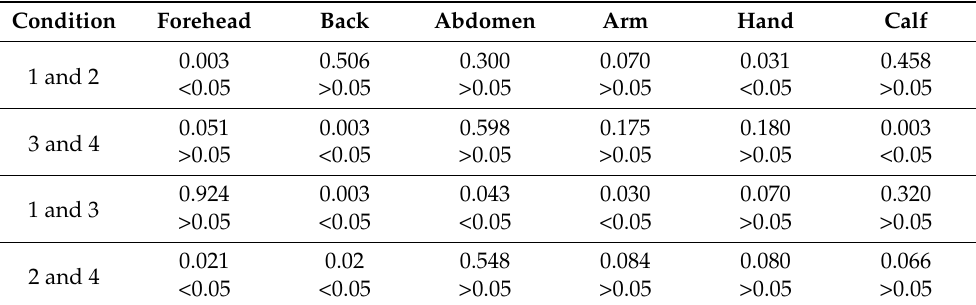
Table 7. Mann–Whitney U test for two independent samples of adult local thermal comfort.